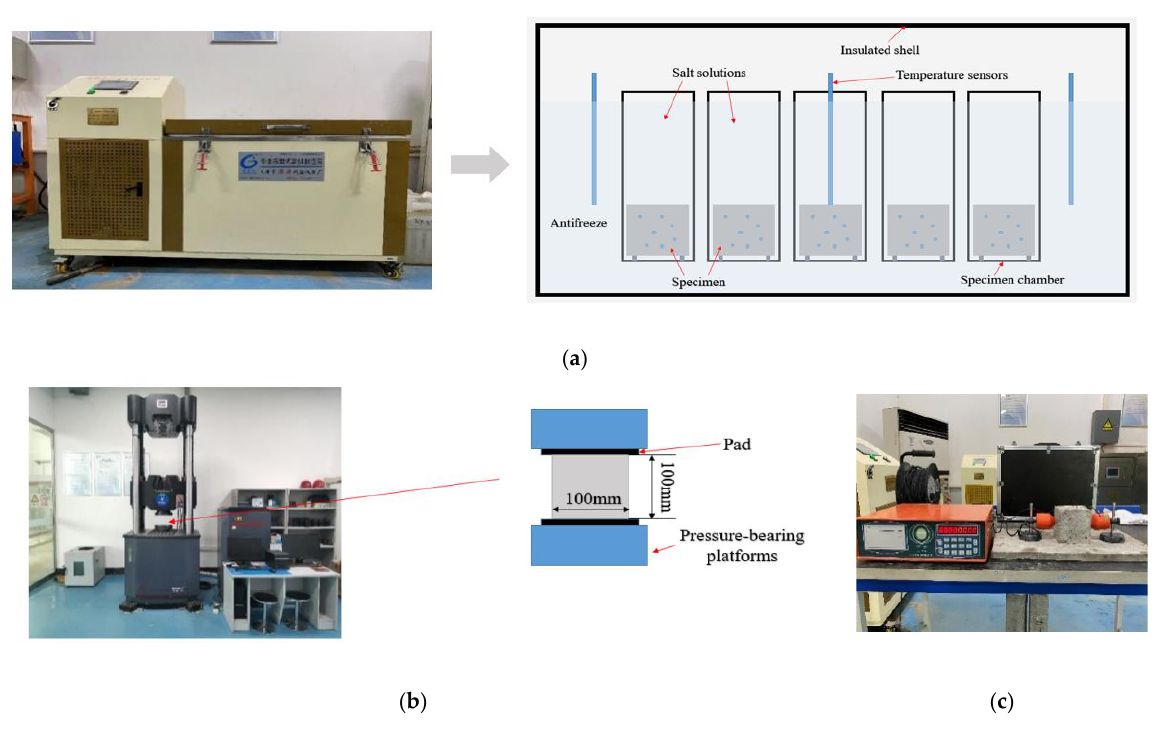
Figure 1. ( a ) Freeze – thaw facility. ( b ) Compressive strength test. ( c ) DT20 dynamic elastometer.